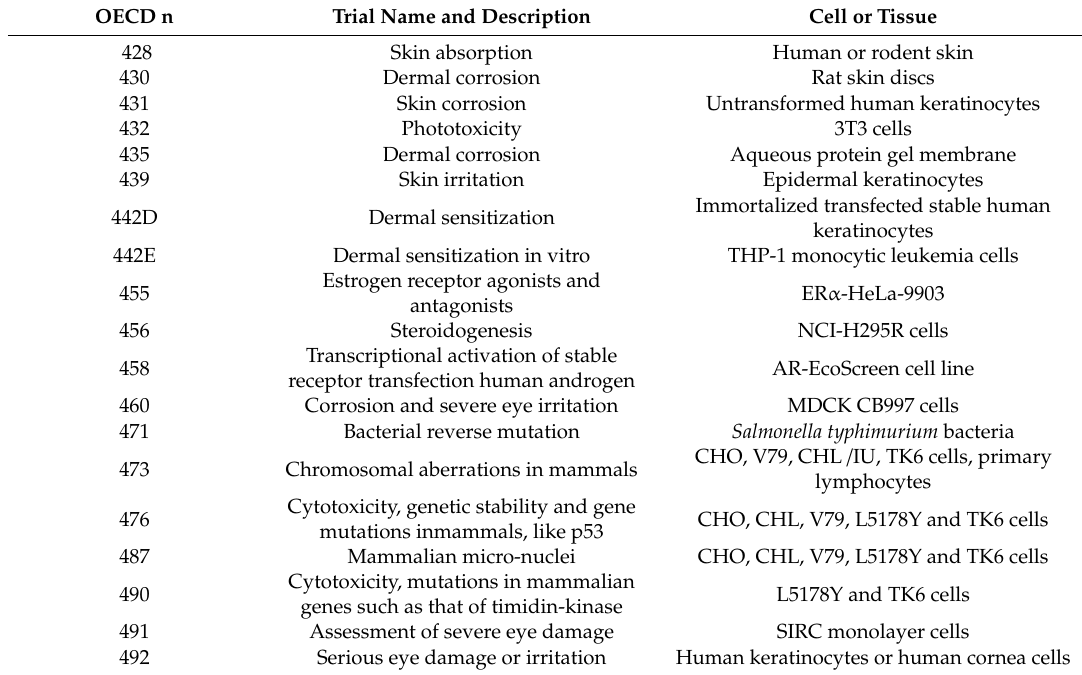
Table 3. In vitro tests regulated by OECD 3